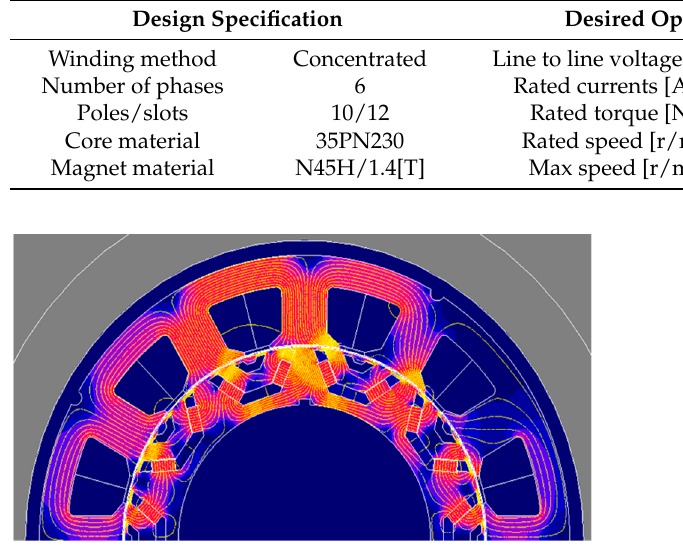
Figure 5. Cross-section of designed six-phase PMSM. Figure 6. Flux density plot of fundamental operation at 10 Arms. Figure 6. Flux density plot of fundamental operation at 10